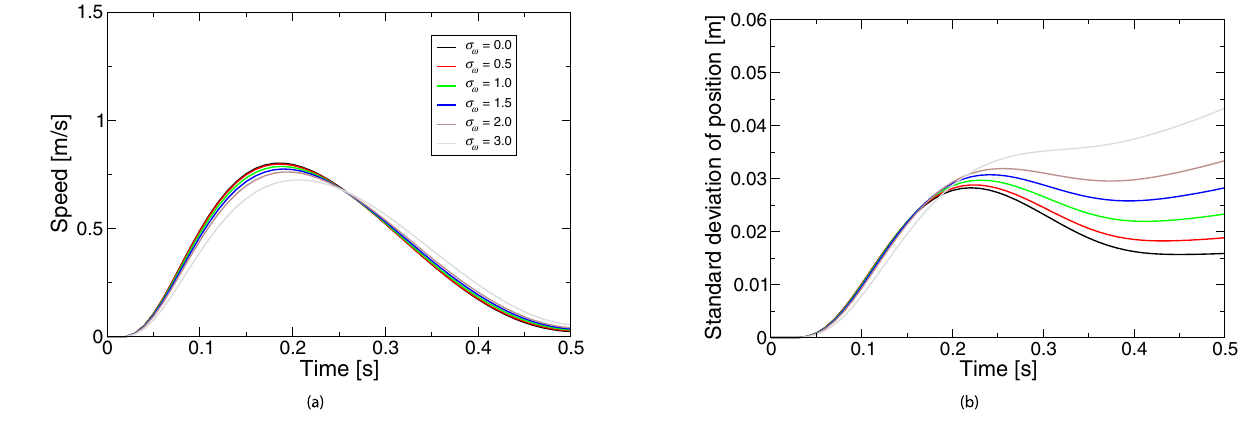
Figure 5. Simulated movements based on the extended LQG for the coefficient σ ω of state-independent observation noise: ( a ) speed, ( b ) positional variability. The legend of the subfigure ( b ) is the same as the subfigure ( a ).